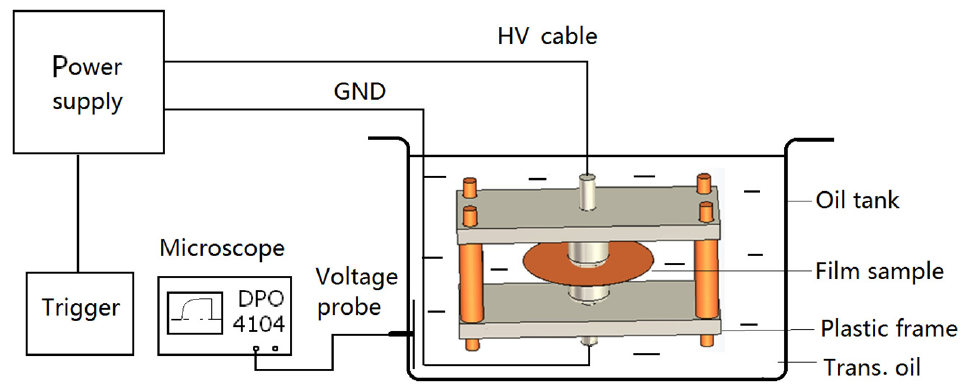
Figure 1. Experimental setup to test the U BD of n -layer films. The samples are made of polypropylene (PP) films with a thickness of 10 µ m. The brand is PHD BOPP. Table 1 lists the key parameters of this type of PP films. Before the test, the electrodes are polished with sandpapers of 1200 grit and cleaned with alcohol to refresh the electrode surface; then, n -layer films are placed together and loaded between the electrodes, immersed into transformer oil, and tested by a gradually increased voltage. Once breakdown takes place, the frame is taken out of the oil, the breakdown sample is replaced, and the next n -layer sample is tested. When five effective U BD - n data are acquired, the test for the n -layer films is finished. Then, the test for more-layer films is started by repeating the above